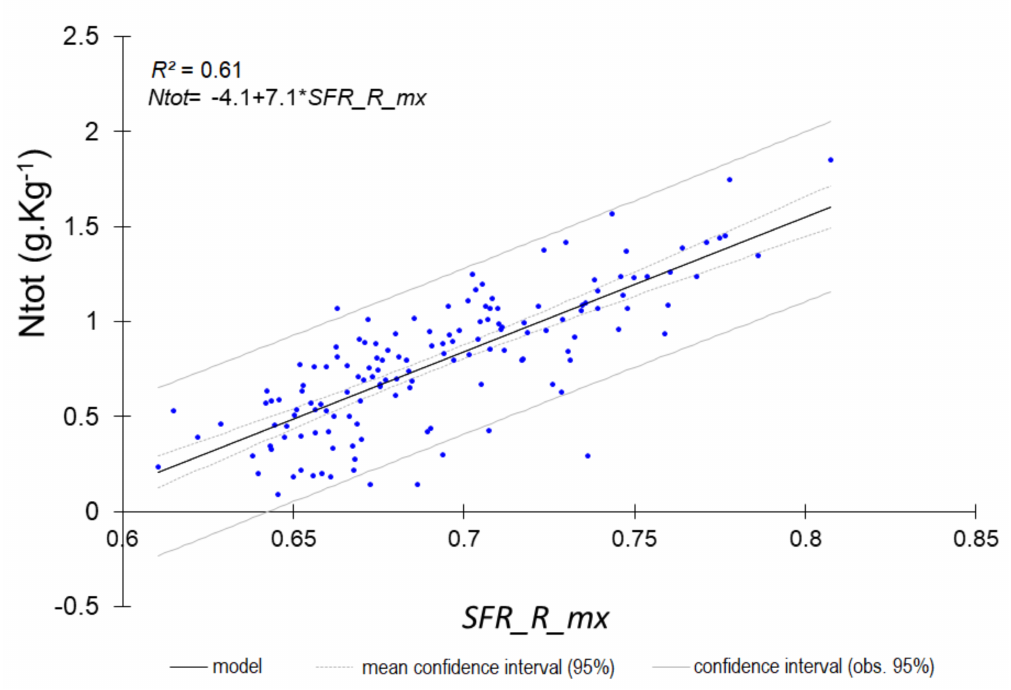
Figure 6. Predicted Ntot from the single SFR_R_mx index (all